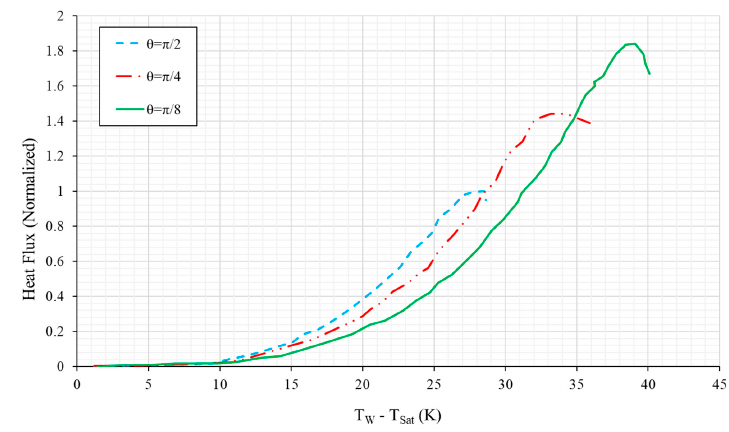
Figure 13. Variations of normalized heat flux versus wall superheat temperature at diverse contact angles. Adapted from Kamatchi and Venkatachalapathy. Reproduced from [162], Elsevier: 2015.